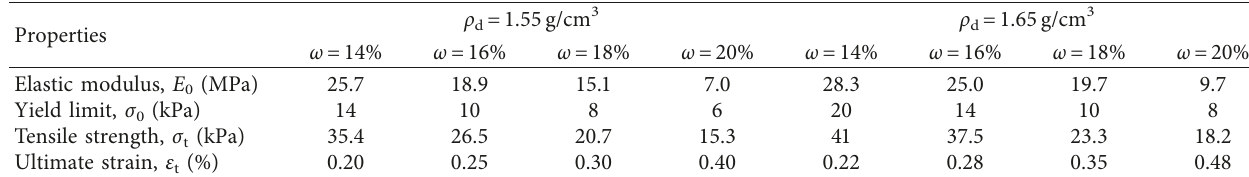
Figure 3: Particle-size distribution curve of the test materials. Table 2: Mechanical properties of the remolded